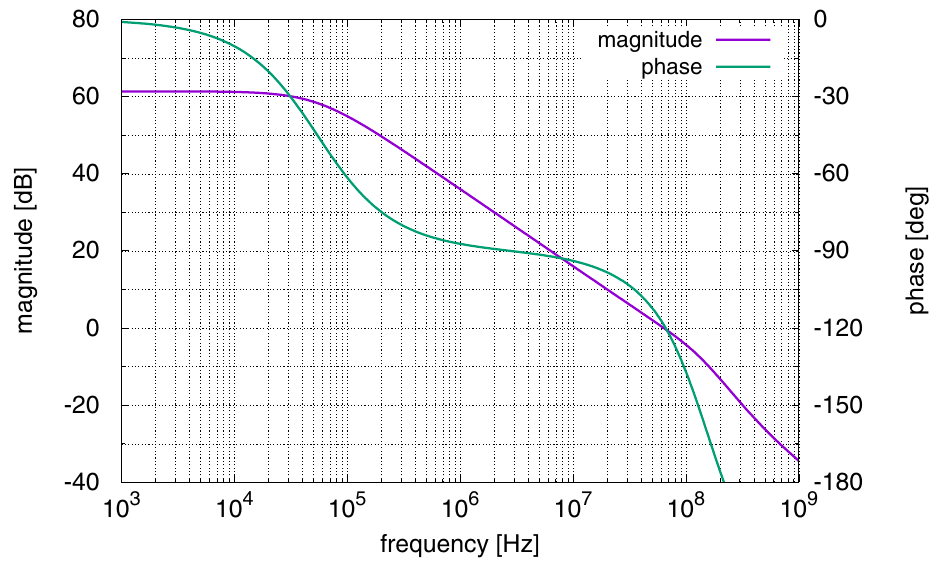
up to 13.2 ns (NST = 0.99) and 17.8 ns (NST = 1.34), for the rising edge and the falling one, respectively.